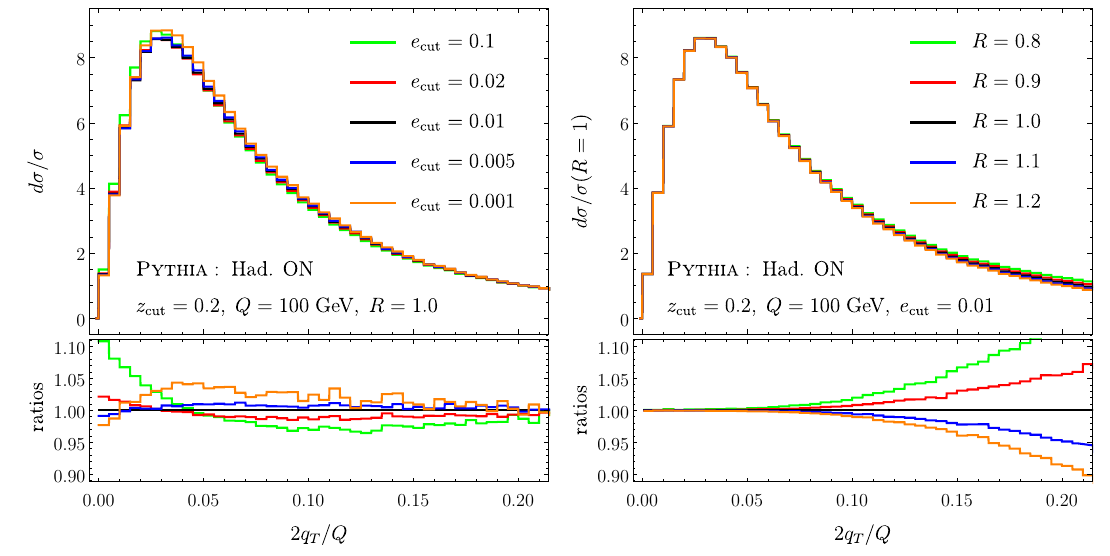
Figure 4 . Left : The normalized cross sections for di(cid:11)erent values of the jet mass cuto(cid:11) parameter e . We also include the corresponding ratios with respect to the case e cut relatively normalized cross section for (cid:12)xed e The corresponding ratios are with respect to R =